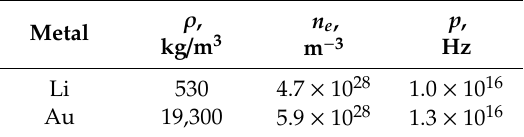
Table 1. Properties of the metals used in the calculations.